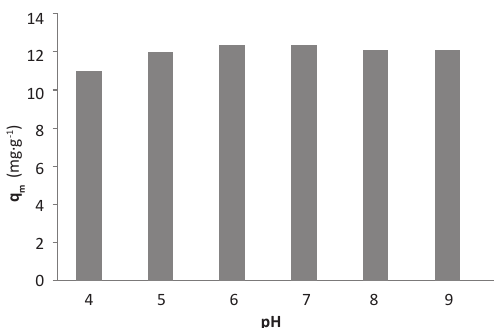
figURe 7. The effect of pH on the adsorption of MB onto poplar sawdust (γ =50 mg·dm -3 , γ =4 g·dm -3 , t=120 dye biosorbent min, T=298.15 K, 150 rpm).